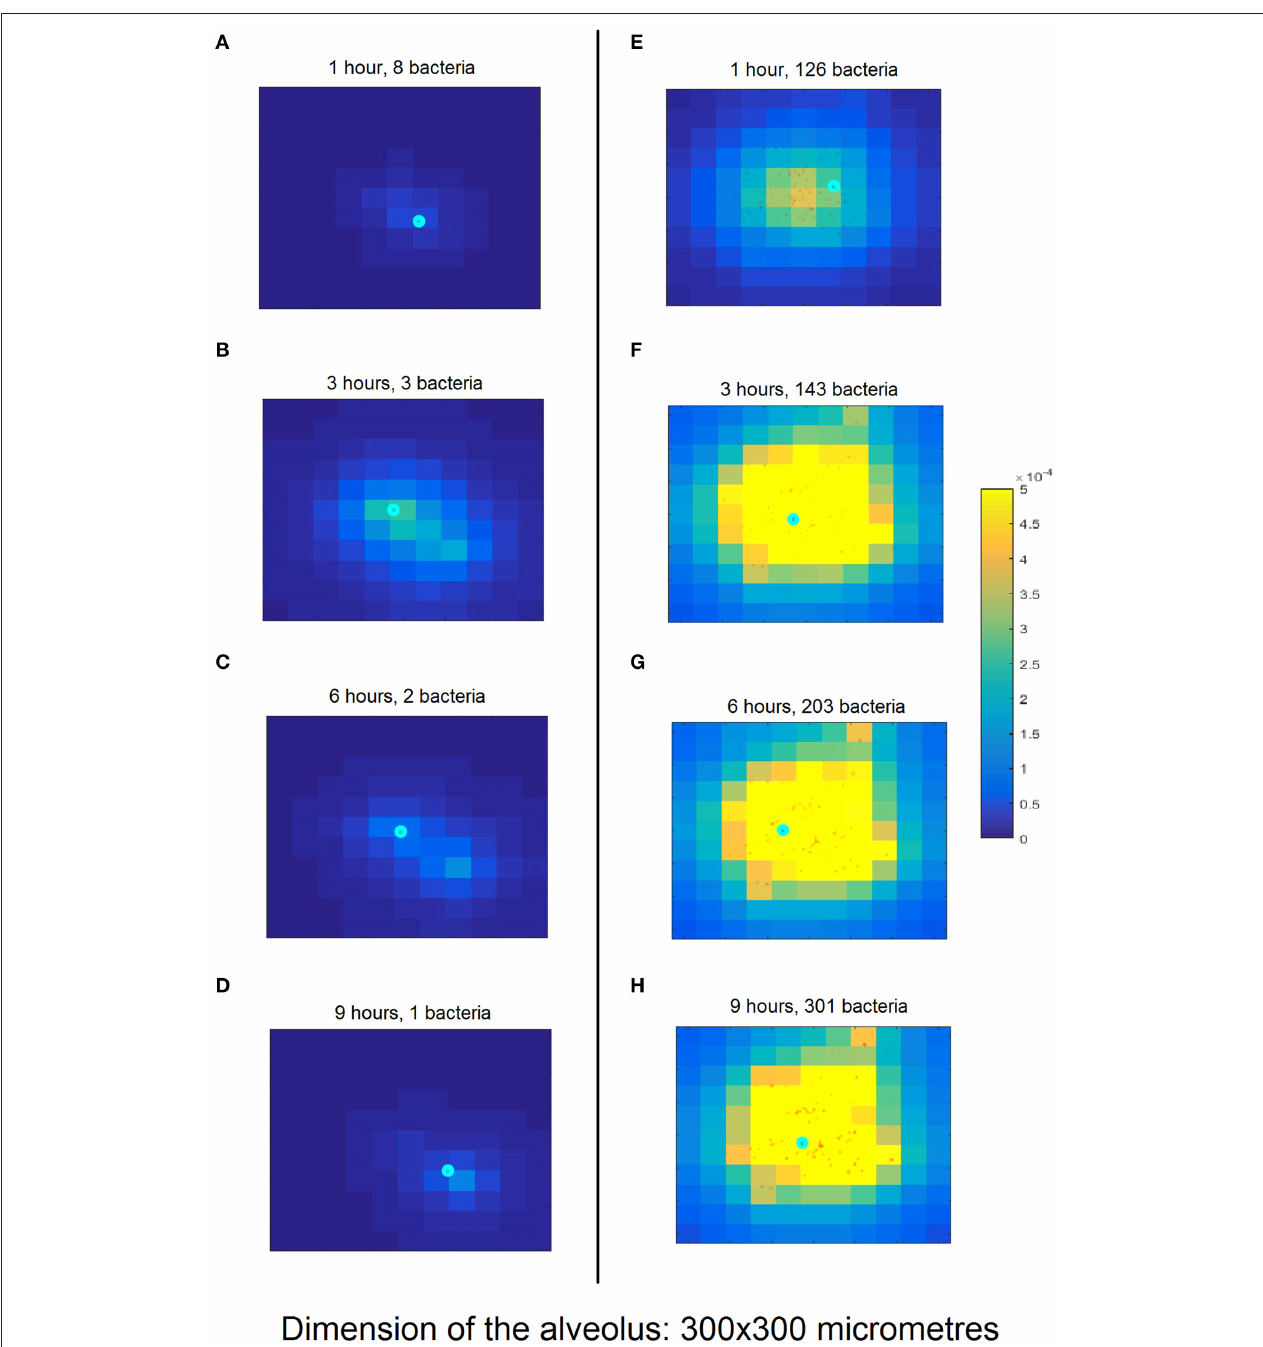
FIGURE 3 | Snapshots of simulation progression at 1, 3, 6, and 9h (cf. rows from top to bottom) for the nominal model parametrization (A–D) compared to an exemplary successful infection (E–H) . (A) The simulation was initiated with 10 bacteria (red dots) and one macrophage (cyan circle). The lighter background color around the bacteria represents the incipient production of MCP-1 from the epithelial cells (square domains in background) in this area. (B) The proliferating bacteria stimulate an increased release of MCP-1 and the macrophage follows the gradient. (C) The macrophage starts phagocytising the bacteria; the production of MCP-1 decreases. (D) The macrophage finds the last remaining bacteria and clears the infection. (E) The simulation begins with 100 bacteria which almost immediately trigger a strong chemokine release. (F) After 3h and massive accumulation of MCP-1, the macrophage clears many bacteria. (G) The number of bacteria keeps increasing, dispersing across the alveolus. (H) After 10h, the bacteria have spread through a wide area on the alveolus. The macrophage is not fast enough to clear all of them and the infection has become productive. Figure S3 provides a clearer representation of the small details of (H) .